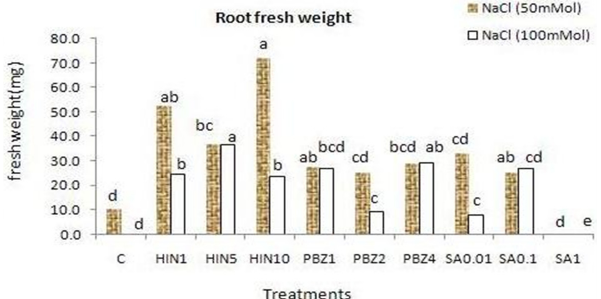
Fig. 4. Effect of hinokitiol, salicylic scid and paclobutrazol on root fresh